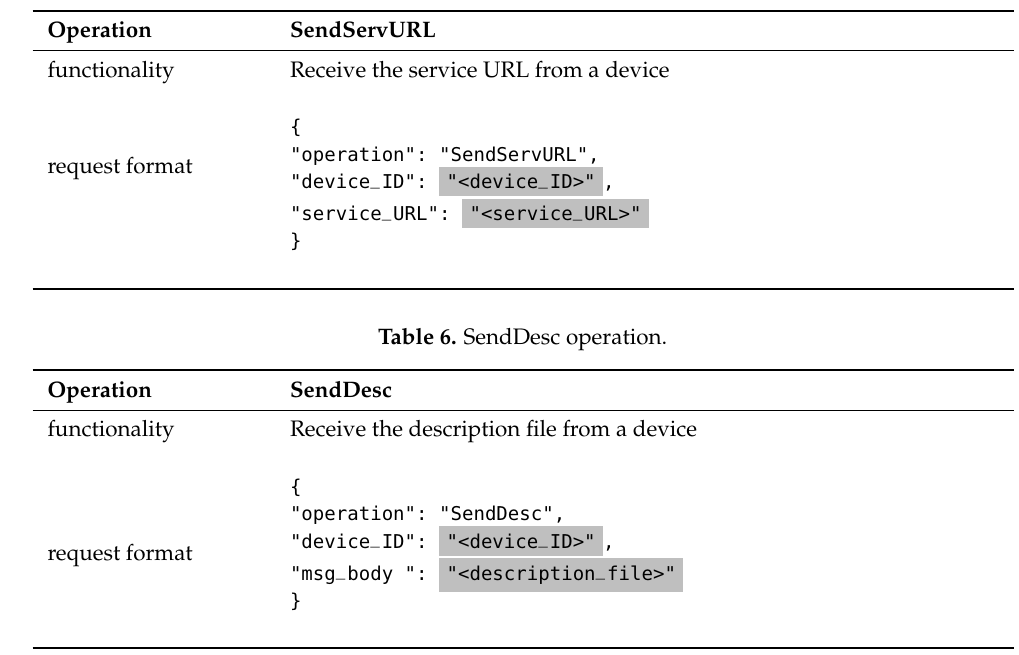
Table 5. SendServURL operation.